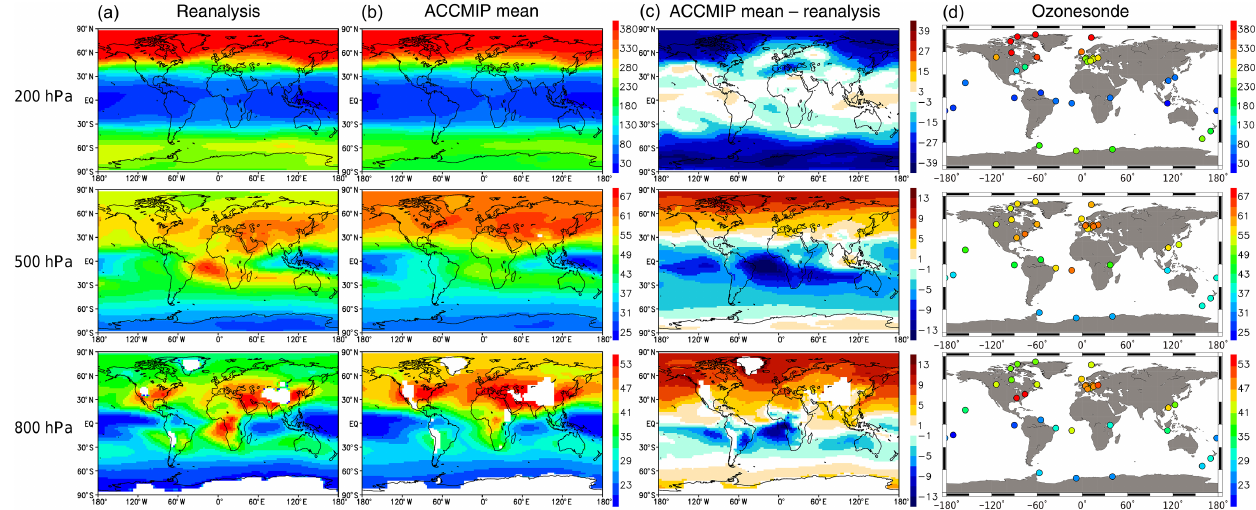
Figure 3. Global distributions of annual mean ozone concentrations obtained from reanalysis (a) , ACCMIP model mean (b) , difference between ACCMIP model mean and reanalysis (c) , and the ozonesonde measurements used for the evaluation of ACCMIP models and ozonesonde sampling biases (d) . From top to bottom, results are shown for global distributions at 200, 500, and 800hPa. Units are